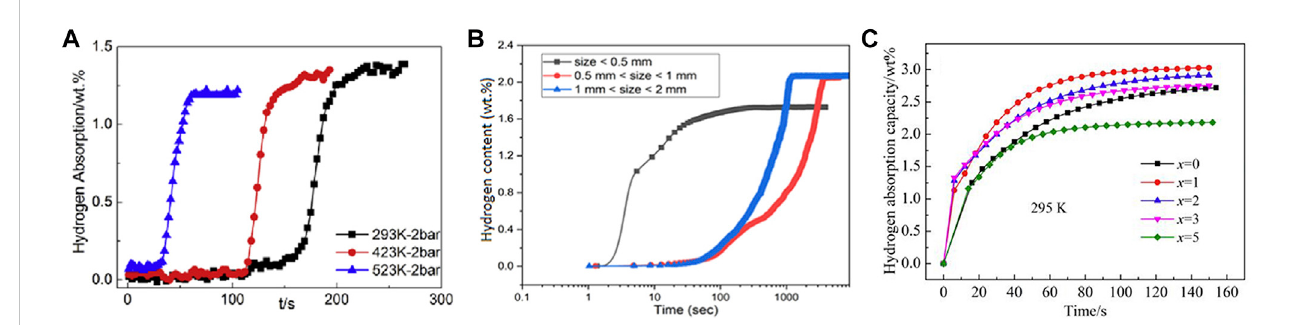
FIGURE 5 Hydrogenation kinetics of TiZrNbTa alloy at different temperatures (A) (Zhang et al., 2020); kinetic curves of TiVZrHfNb alloy with different particle sizes at 300 ° C (B) (Sleiman and Huot, 2021); kinetic curves of (V48Fe12Ti30Cr10) 100-x La x alloy with different La additions (C) (Luo et al.,